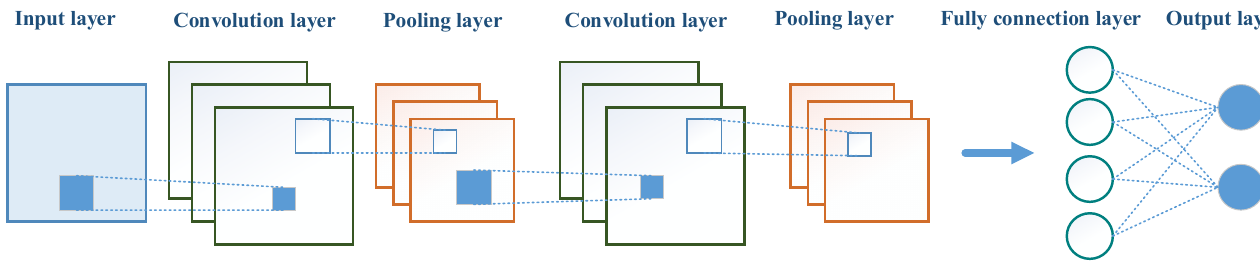
Figure 1. Architecture of convolutional neural